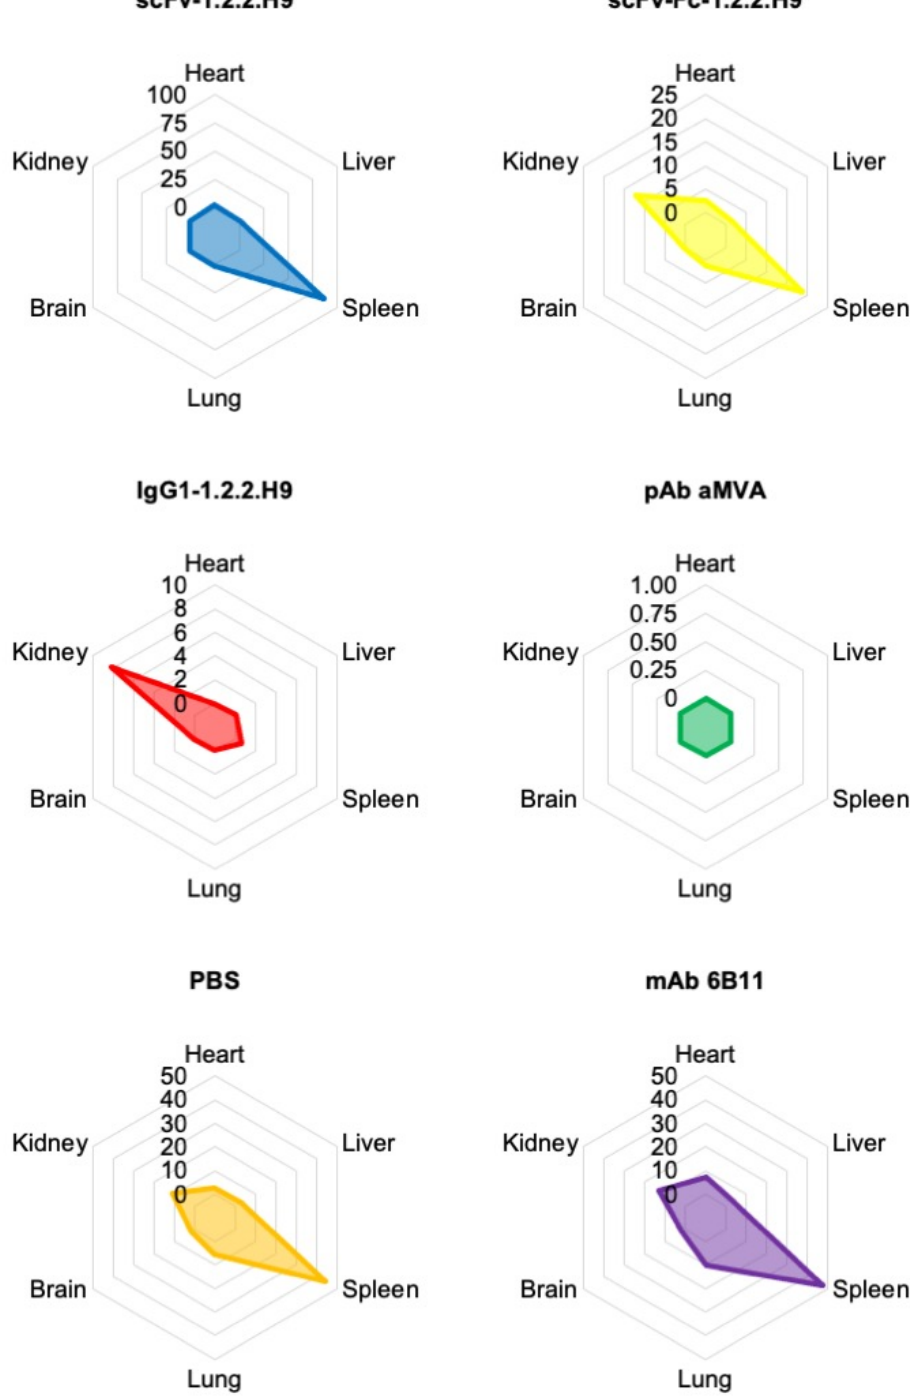
Figure 13. The radar plots show the mean viral loads of the respective treatment groups in genome copies/g